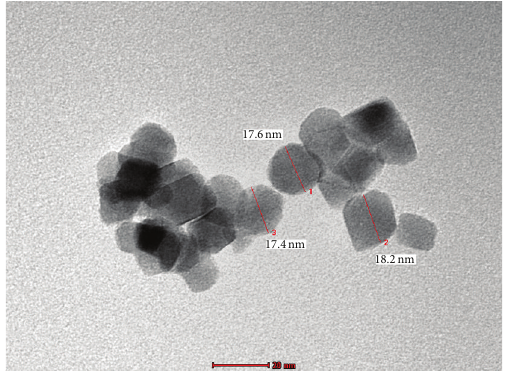
Figure 8: EDX spectra of NCZF.